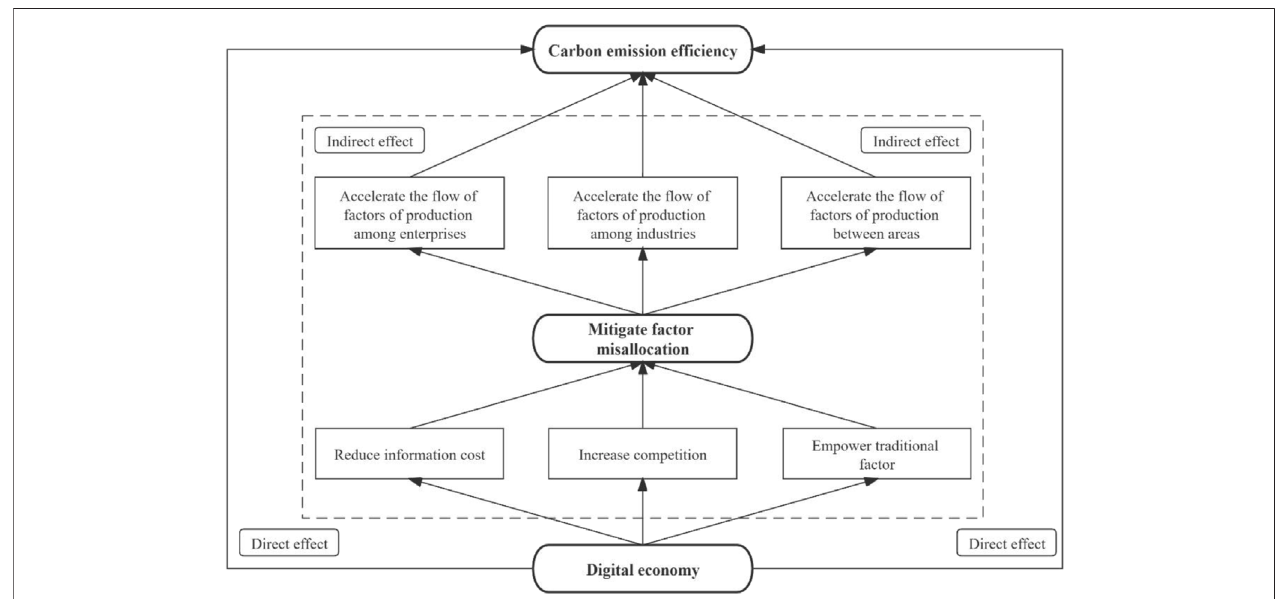
FIGURE 1 | Theoretical mechanism